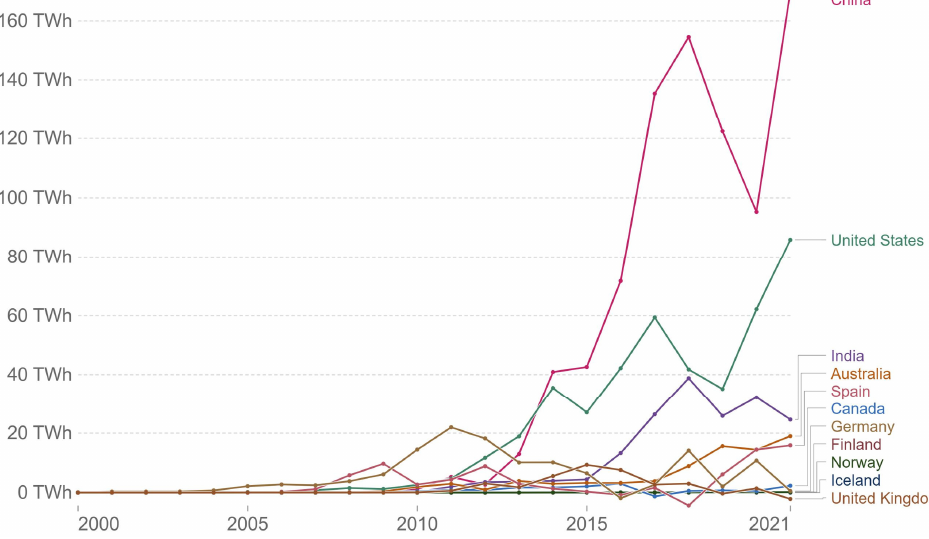
Figure 9. Annual change in wind energy generation across different country [41]. 3.3. Global EV Research The global trends in research on EV and its related aspects are comprehensively reported in this section. In ref. [42], Kazemzadeh et al. examined the influence of BEVs and PHEVs that can reduce the release of fine particulate maer (PM2.5) with the application of the moment’s quantile regression (MM-QR) which has been investigated considering a panel of 29 European nations from 2010 to 2019. The research work examined the association between